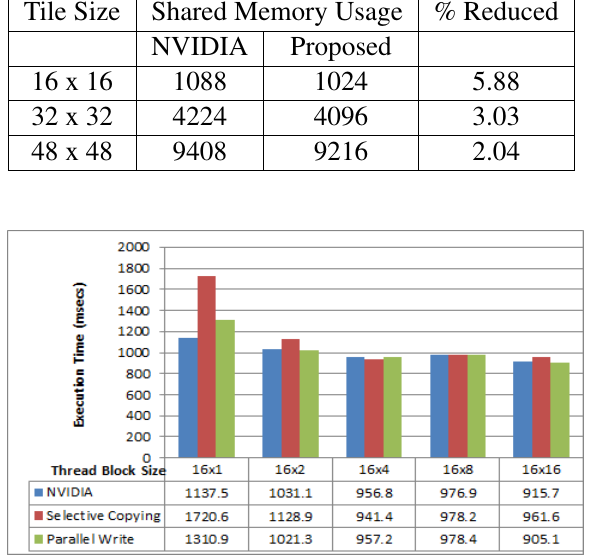
Figure 4: Exec. time for the three implementations with Tile Size = 16 x 16